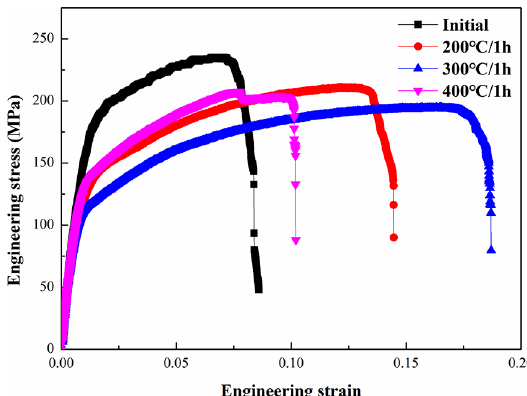
Figure 9. Engineering stress-strain curves of EXW + rolled composite plates annealed at different temperature for 1